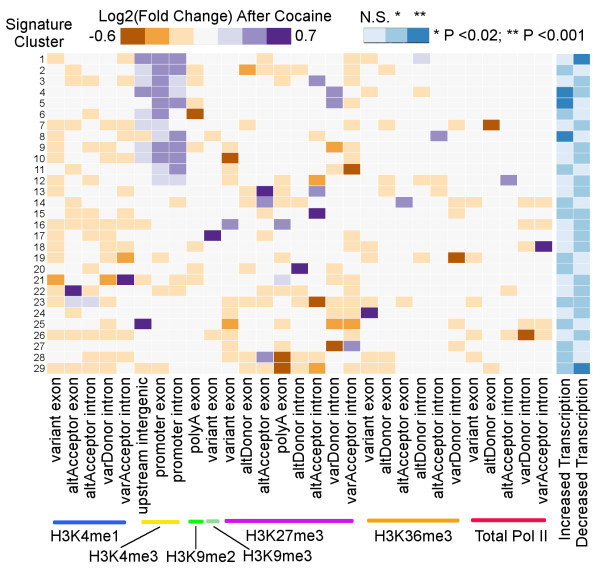
Heatmap of cocaine-regulated chromatin modifications of the 29 signature clusters that associate with transcriptional regulation. In the left panel, each row represents a cluster and each column represents an epigenomic mark at a specific genomic region; each square represents the averaged chromatin modification change in log2 scale; purple and orange colors indicate increased or decreased binding and the darkness indicates the magnitude of change. The heatmap in the right panel illustrates the statistical significance of each cluster’s association with transcriptional change. N.S., not significant.